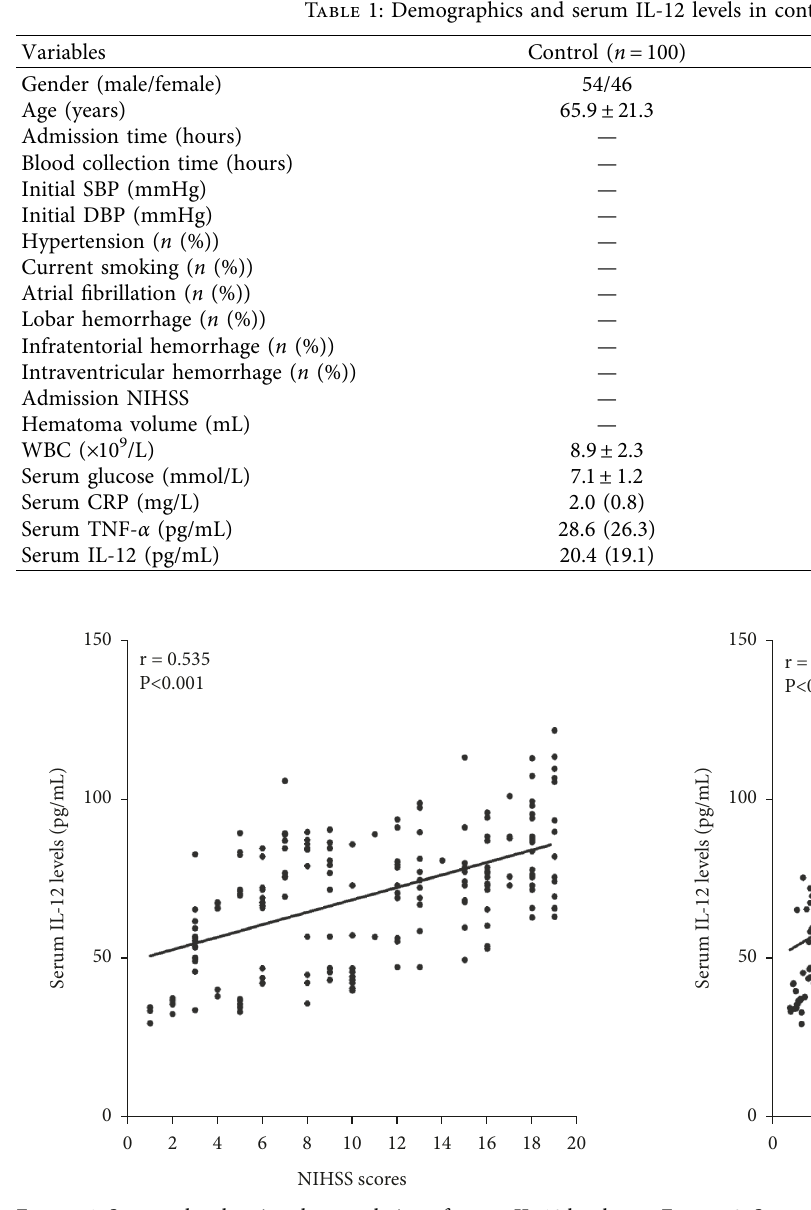
Figure 2: Scatter plot showing the correlation of serum IL-12 levels with hematoma volume using Spearman’s correlation